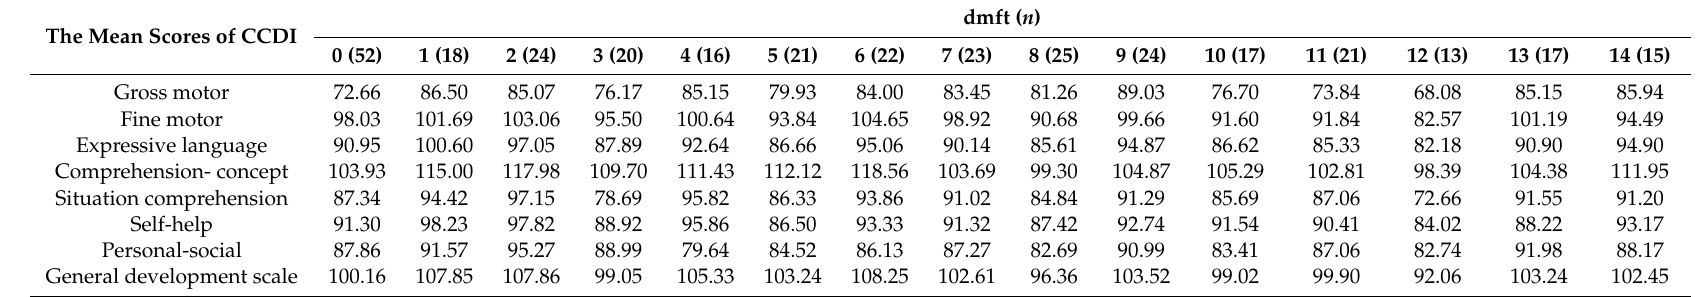
Table 3. The mean scores of CCDI measured with di ff erent dmft scores